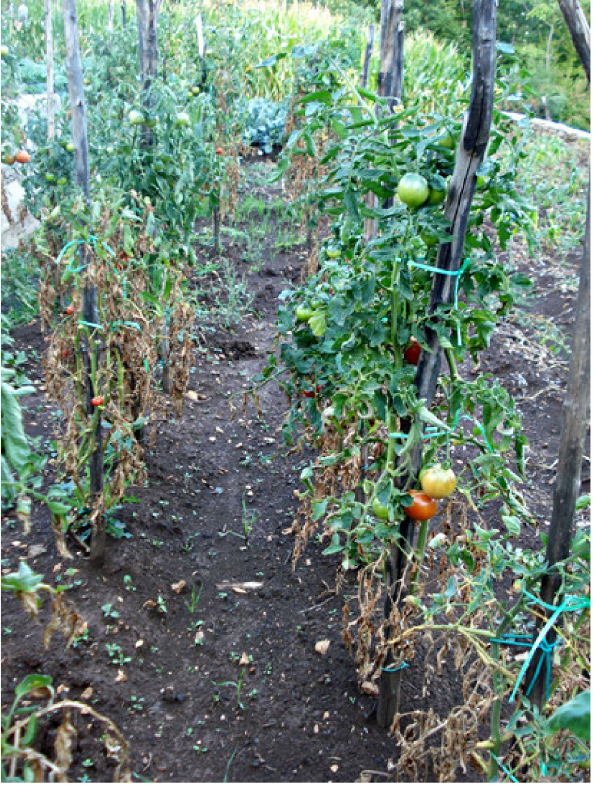
Figure 8. Bacterial speck disease caused by Pseudomonas syringae pv. tomato . The principal dissemination of Pst occurs through infected seeds, but long-distance spread through the atmosphere is also documented, due to its presence in rain and snow